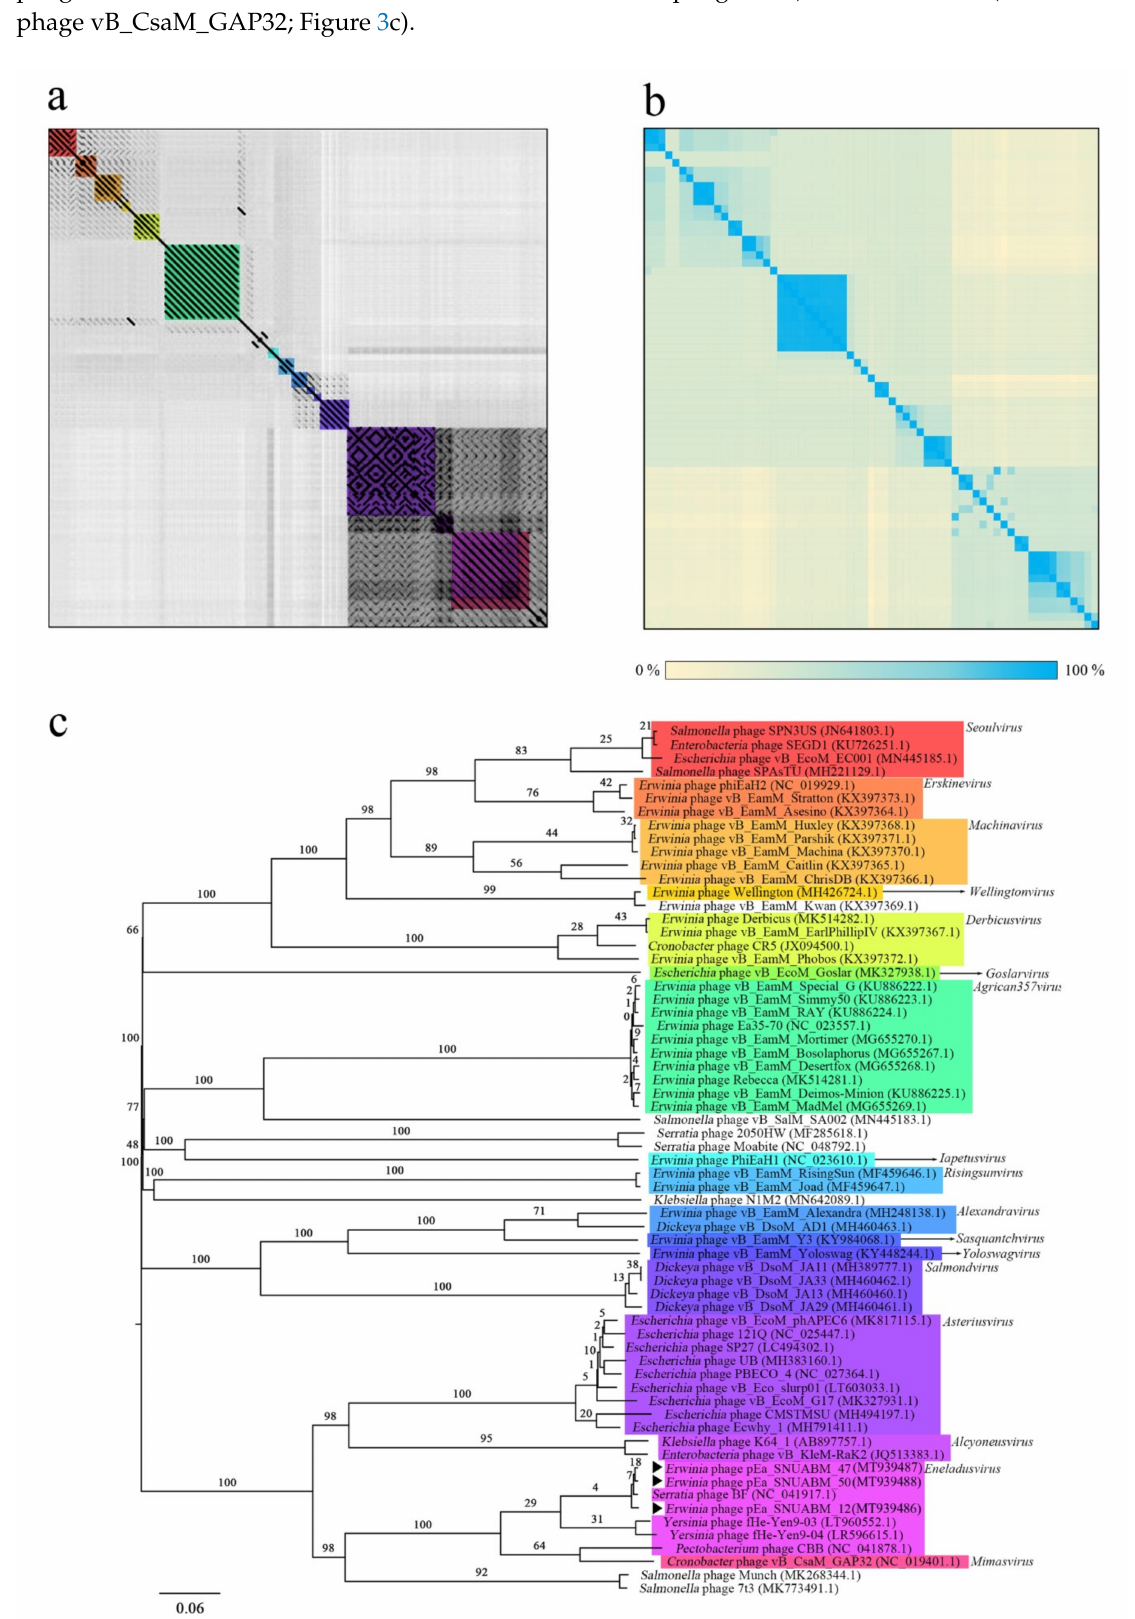
Figure 3. Whole genome phylogenetic analysis of Myoviridae jumbo phages infecting Enterobacterales